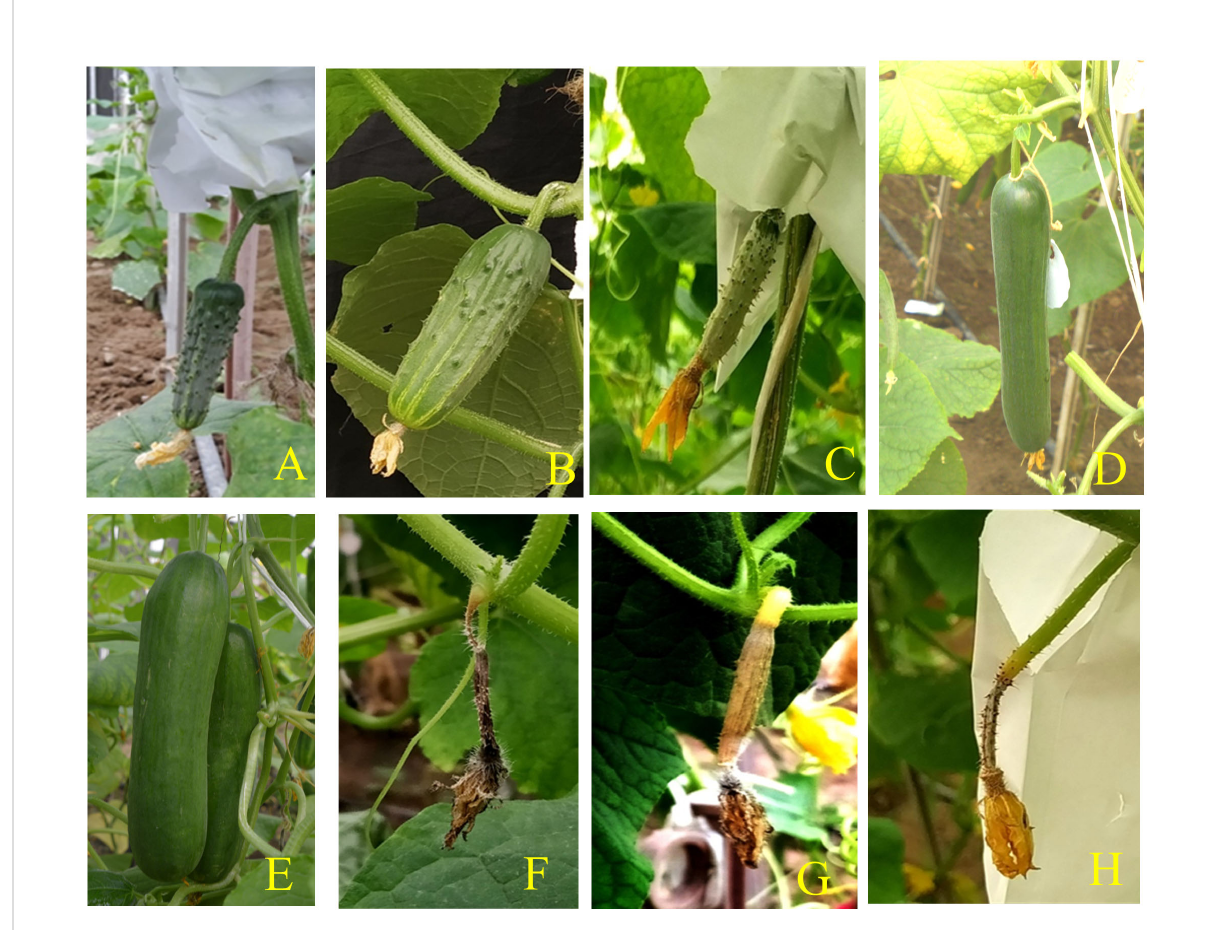
FIGURE 3 The pattern of fruit set in the segregating population at 10 days after anthesis (A-H)